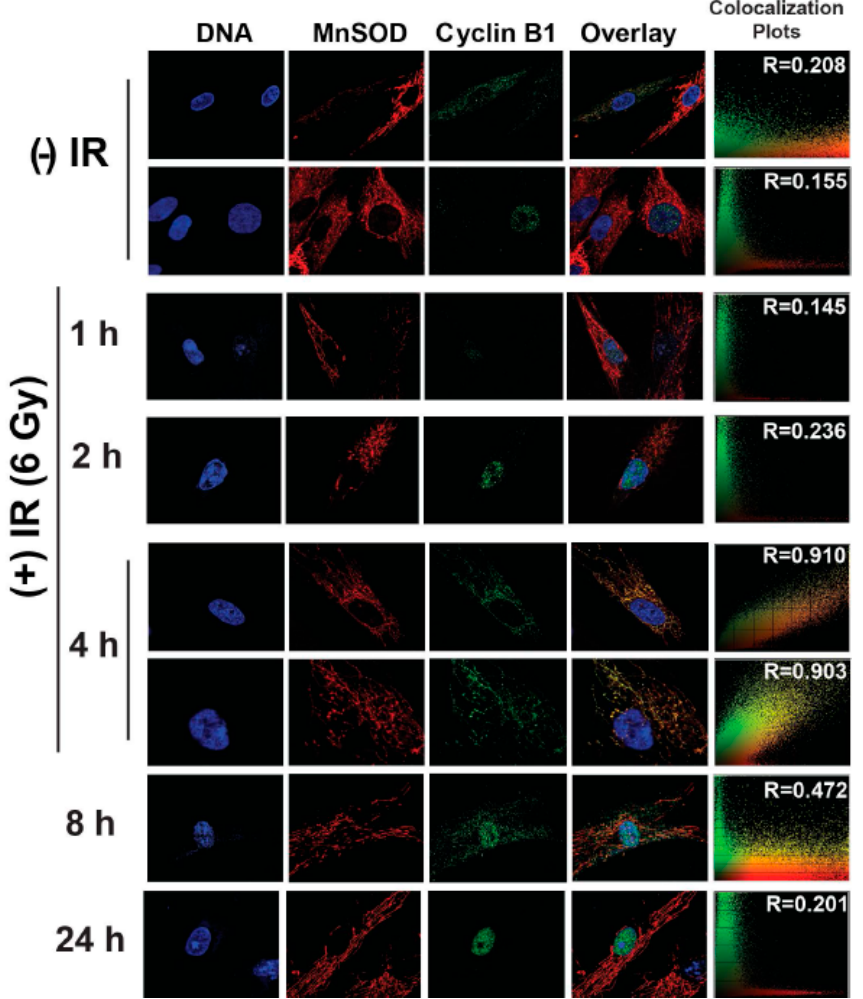
Figure 4. Cyclin B1 mitochondrial translocation following oxidative stress is a transient response. Synchronized NHFs were irradiated with 6 Gy and harvested at the indicated time post-irradiation,